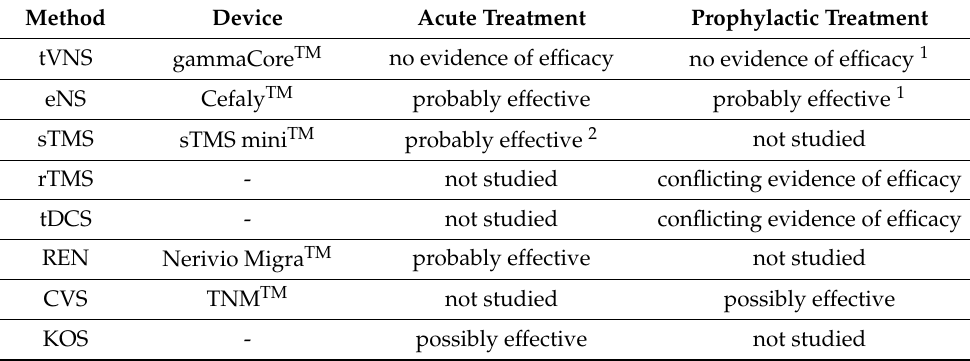
Table 1. Different types of non-invasive neurostimulation in the acute and prophylactic treatment of migraine with the probability of